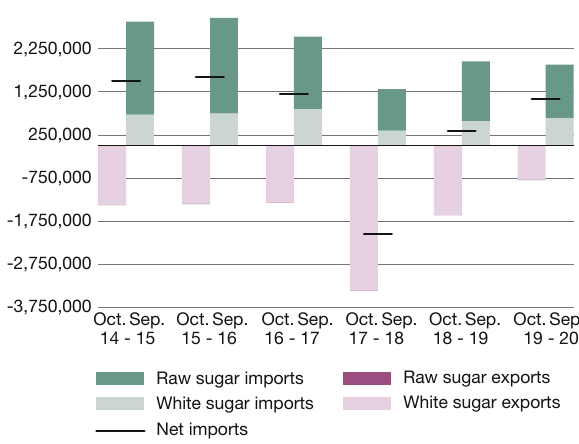
Figure 2 Imports and exports of raw and white sugar, EU28 to and from the rest of the world in millions of euros